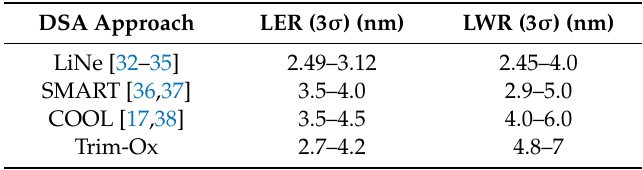
Table 2. LER and LWR values for various approaches that include LiNe, SMART, COOL, and the Trim-Ox approach presented in the following